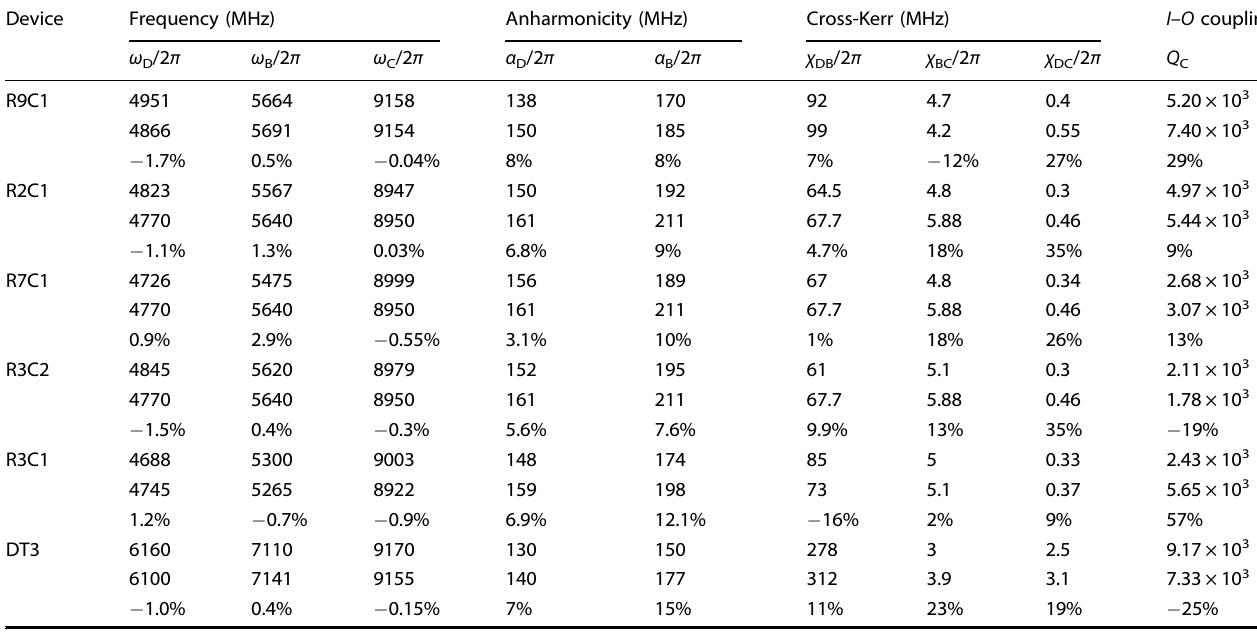
Table 1. Two-qubit, one-cavity devices. Device